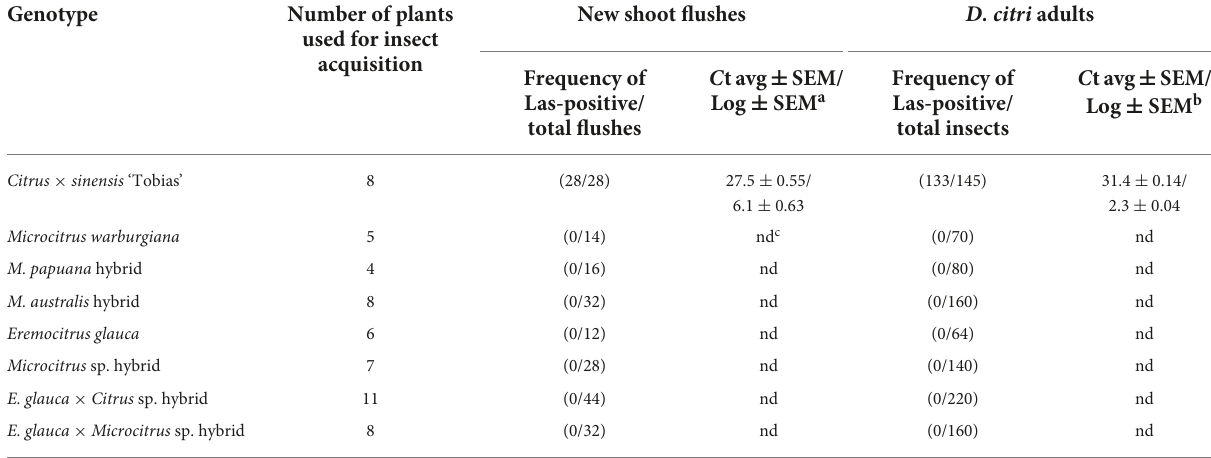
TABLE 3 Acquisition of ‘ Candidatus Liberibacter asiaticus’ (Las) by Diaphorina citri reared for 72 h on new shoot flushes from plants of seven Oceanian citrus genotypes and ‘Tobias’ sweet orange as control, all grafted onto Las-infected ‘Rangpur’ lime rootstocks.